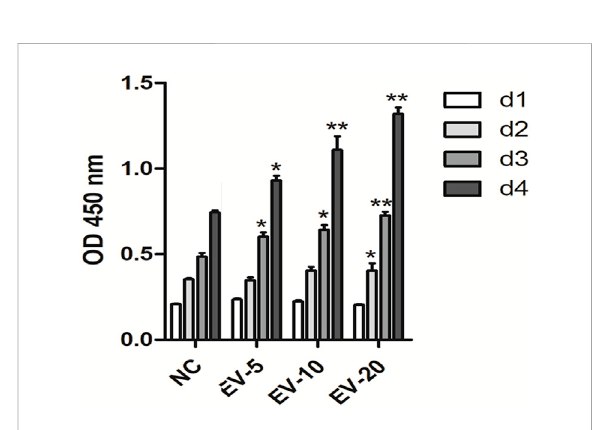
FIGURE 4 The effect of hMSC-Exo to human fi broblasts proliferation. * p < 0.05, ** p < 0.01, compared to NC